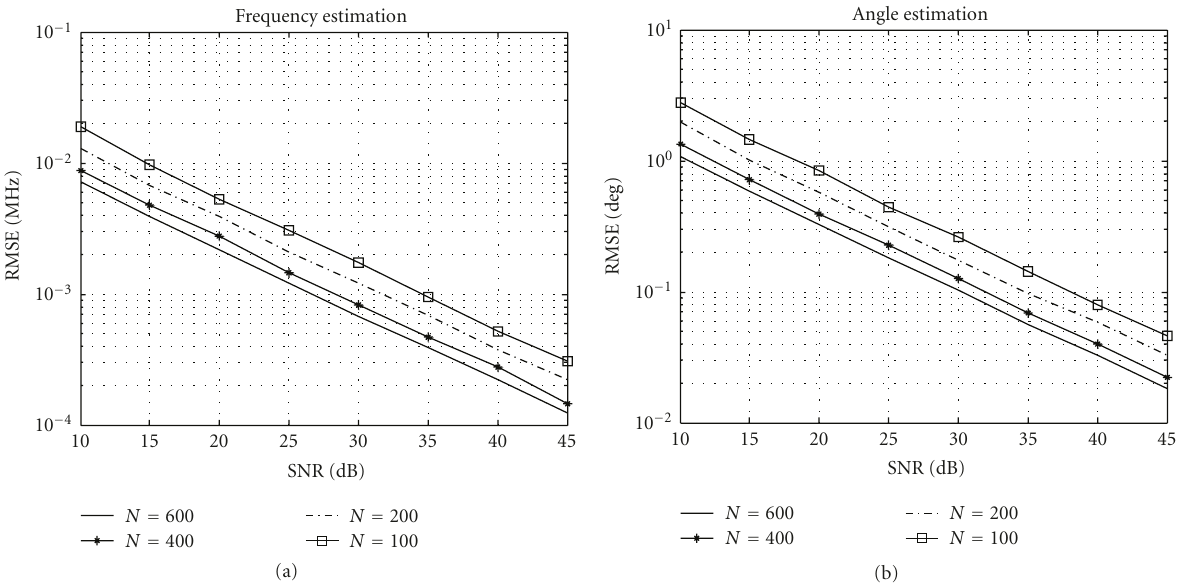
Figure 5: Angle-frequency estimation with di ff erent snapshot N .